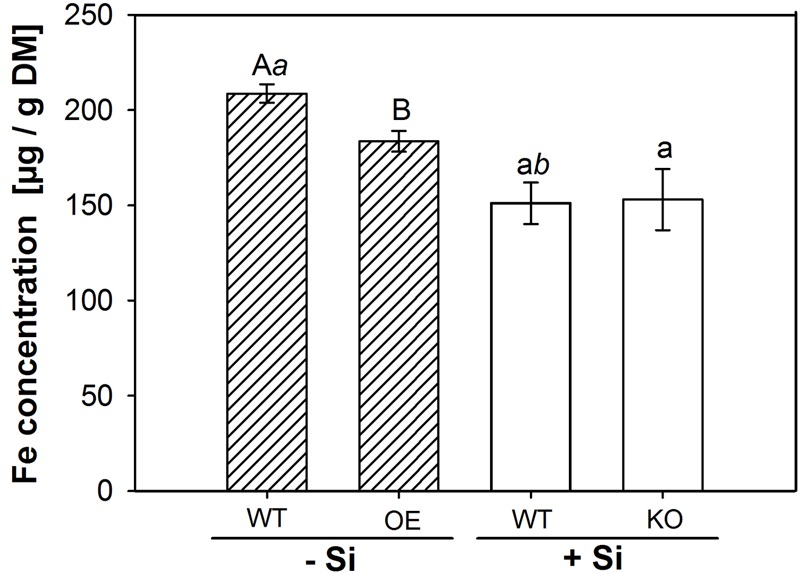
Iron content in shoot dry matter. The WT plants were grown with low (–Si) and high (+Si) Si supply (conc. are given in the legend of Figure 1), whereas the insertion line 1B-14436 (KO) was cultivated only in +Si and mutant 3A-16329 (OE) only in –Si. Different capital, small and italic letters indicate a significant difference between treatments; students t-test with p < 0.05.